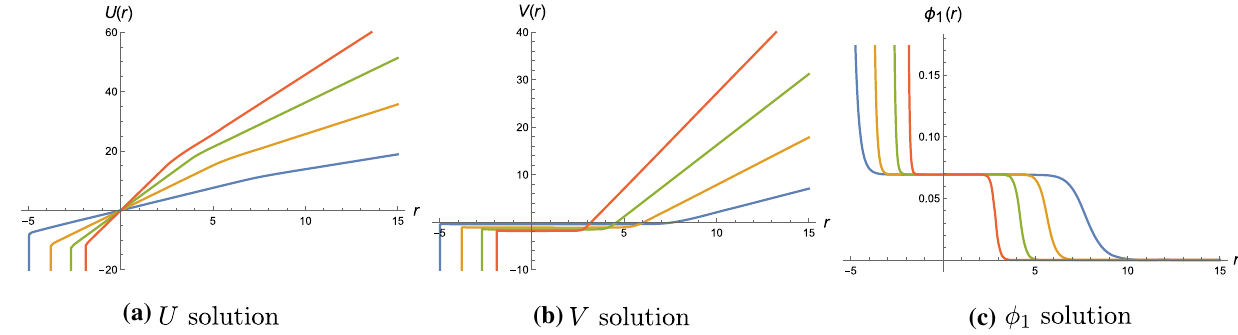
Fig. 7 RG flows from the N = 4 AdS 7 critical point to the AdS 4 × H 3 fixed point and curved domain walls for SO ( 3 ) twists with φ 1 → ∞ . The blue, orange, green and red curves refer to g = 8 , 16 , 24 , 32, respectively